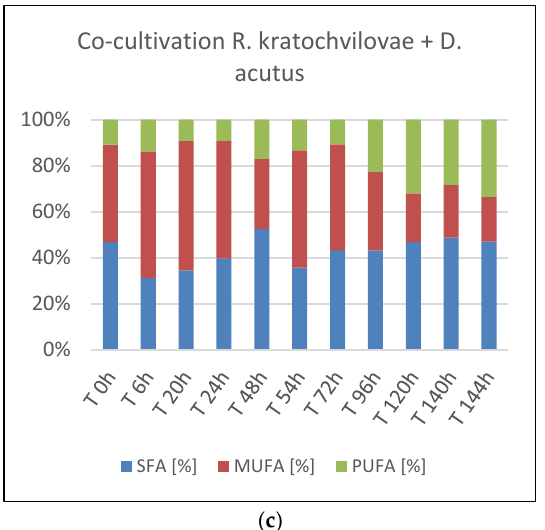
Figure 8. Fatty acid distribution in co-cultures of R. kratochvilovae and Desmodesmus sp. Microalgae. ( a ) — Co-cultivation Rhodotorula kratochvilovae with Desmodesmus quadricauda ; ( b ) — Co-cultivation Rhodotorula kratochvilovae with Desmodesmus dimorphus ; ( c ) — Co-cultivation Rhodotorula kratochvilovae with Desmodesmus acutus .